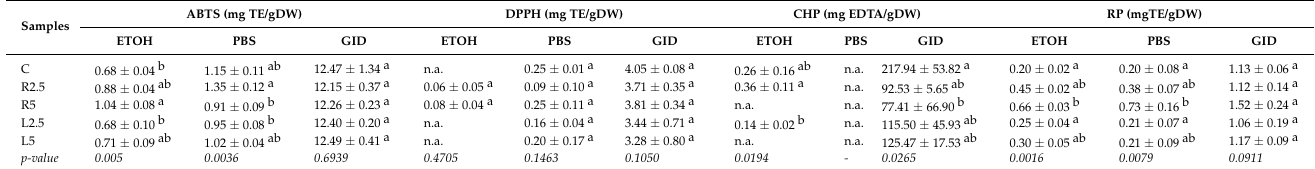
Table 4. Antioxidant properties of pasta supplemented with dried Reishi and Lion’s Mane